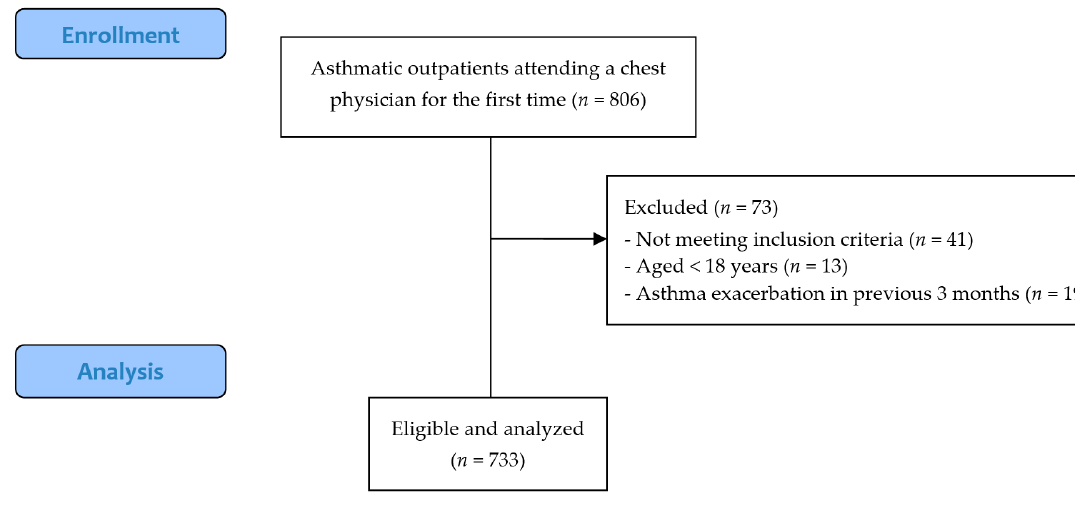
Figure 1. Flowchart of participants’ inclusion. n : number of subjects.